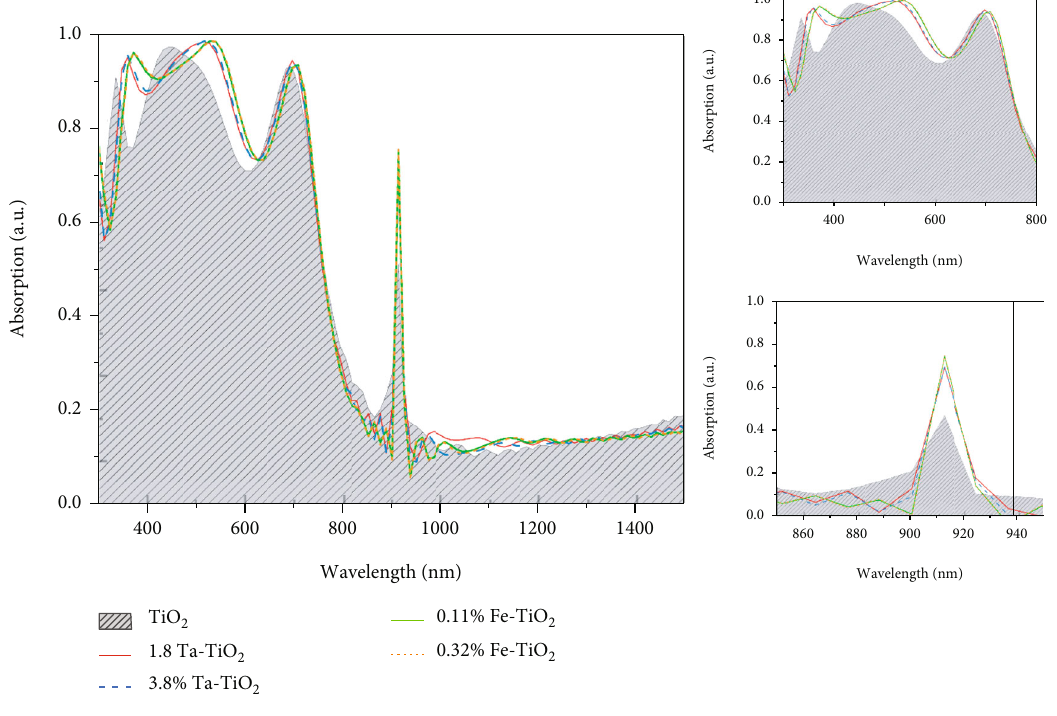
Figure 3: The spectral absorption of PSC with doping variations of TiO